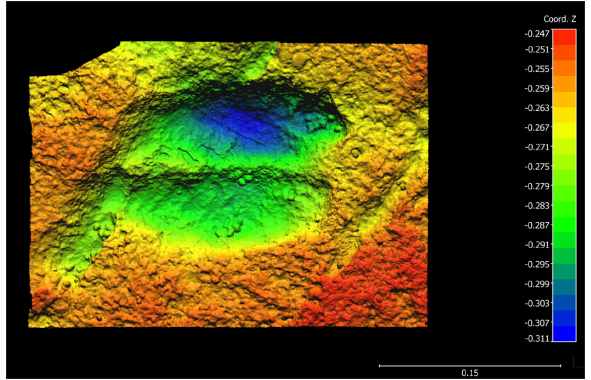
Figure 6: Tight view of a single giraffe track with same photogrammetry metrics as Figure 5. Vertical and horizontal scales are in metres.